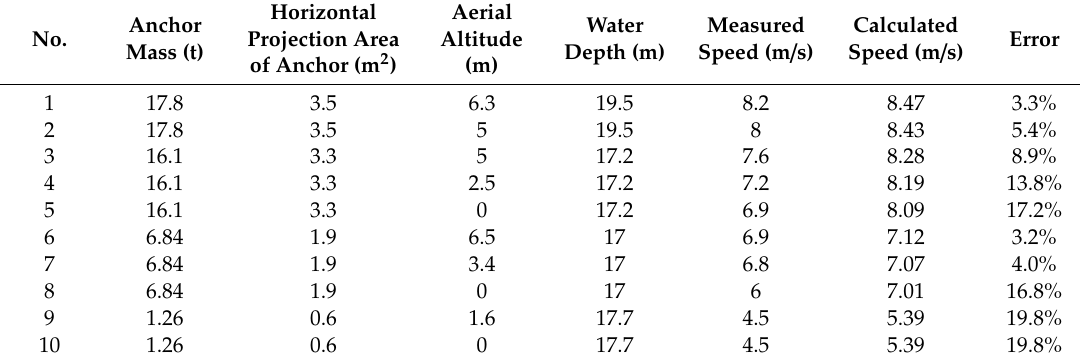
Table 1. Comparison of calculated and measured bottom speeds.